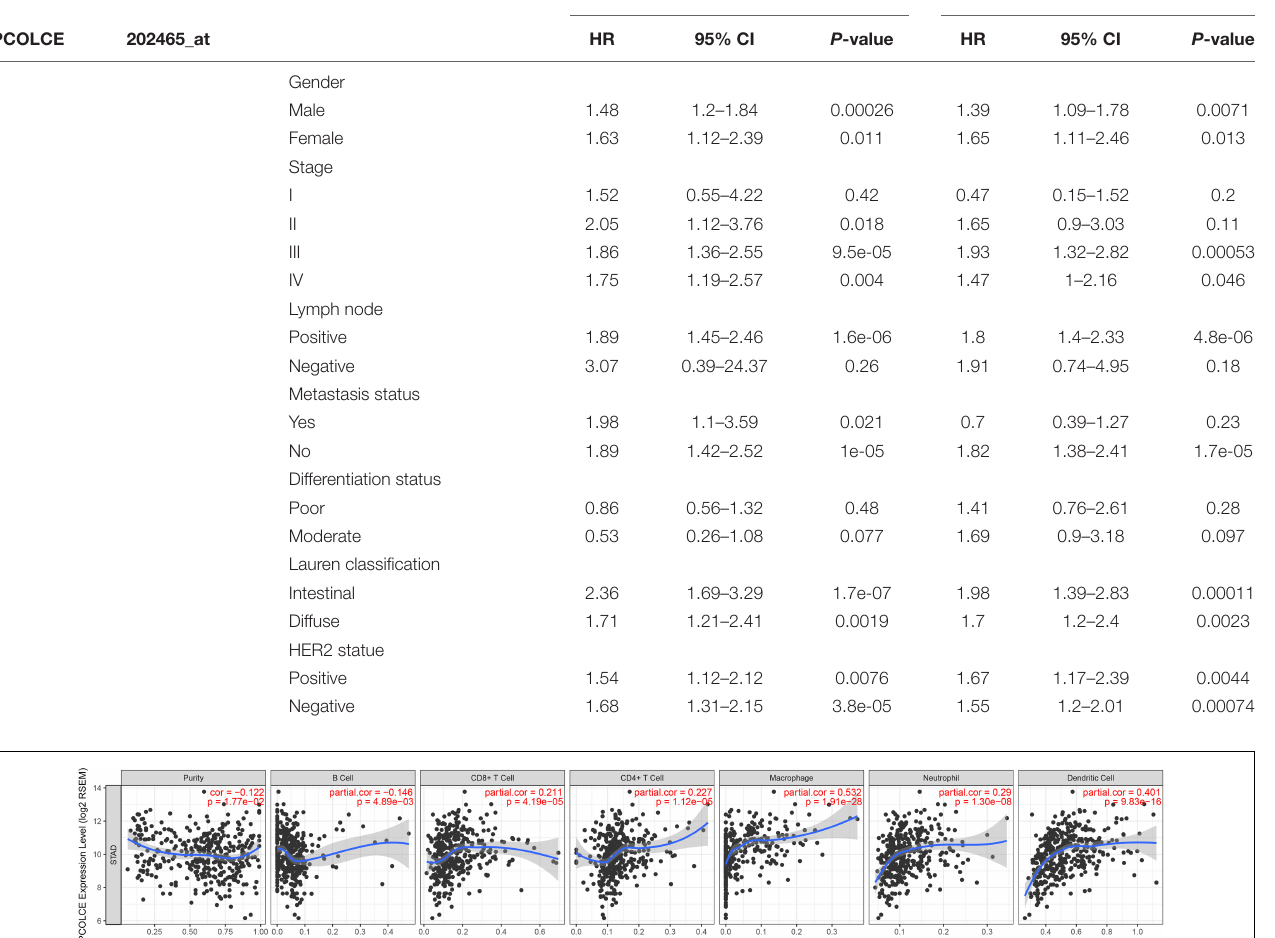
TABLE 1 | Correlation of PCOLCE mRNA expression and clinical prognosis in gastric cancer with different clinicopathological factors by Kaplan–Meier plotter.